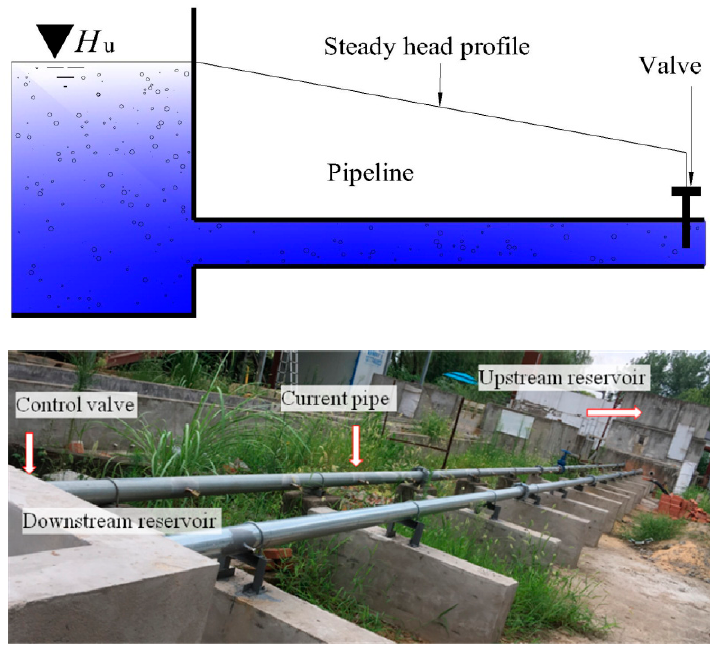
Figure 2. Pipe flow system for water hammer analysis.